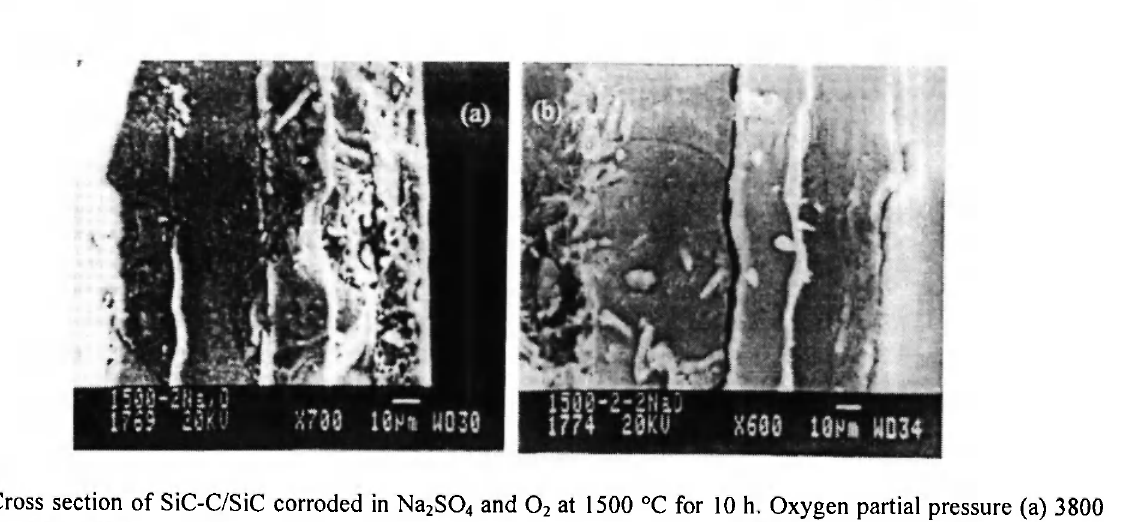
Fig. 4: Cross section of SiC-C/SiC corroded in Na 2 S0 4 and 0 2 at 1500 °C for 10 h. Oxygen partial pressure (a) 3800 Pa, (b) 8000 Pa.